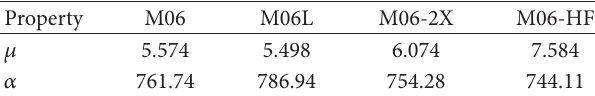
T 1: Molecular dipole moments